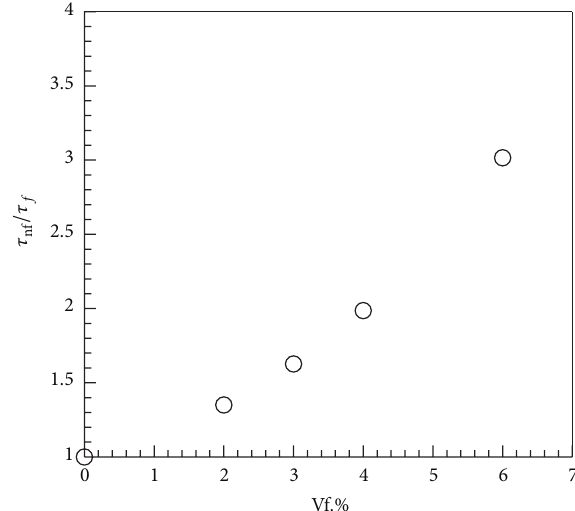
Figure 6: Effect of nanoparticle concentration on average wall shear stress ratio.